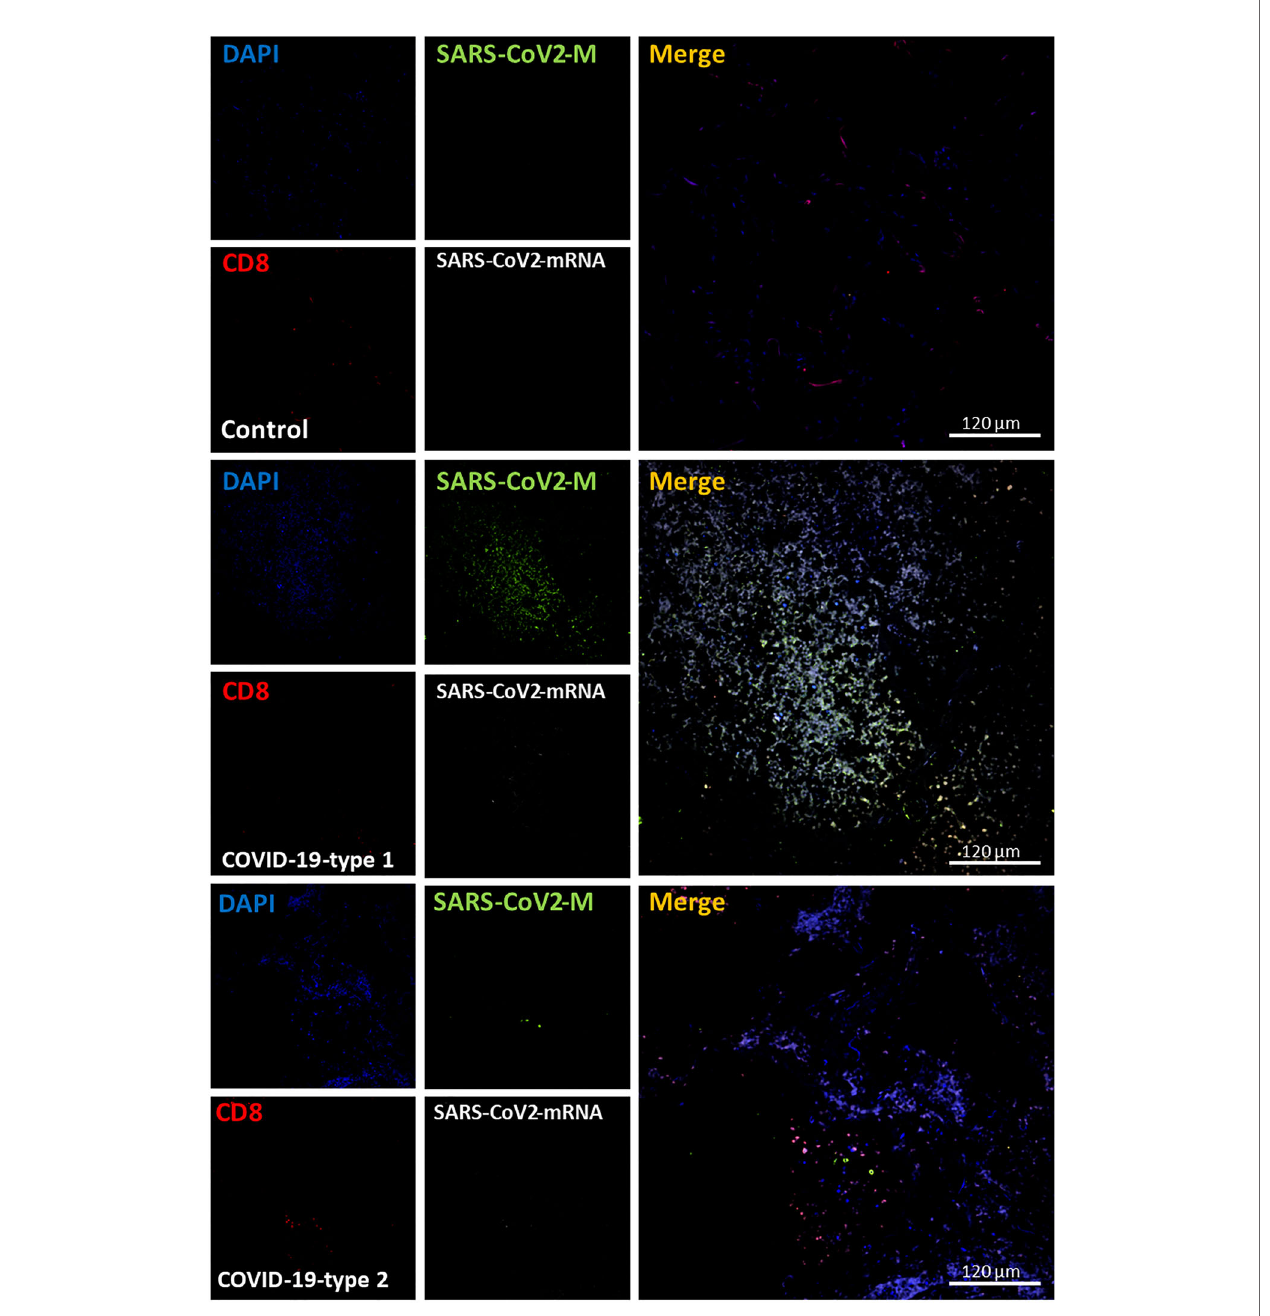
FIGURE 7 | COVID-19 disease induces a small but signi fi cant in fi ltration of CD8 + lymphocytes into the lung. Staining for nuclei (DAPI, blue staining), SARS-CoV-2 protein M (SARS-CoV-2-M, green staining), CD8 + lymphocytes (CD8, red staining), and SARS-CoV-2-mRNA (White staining) was performed. 3D reconstructions of lung samples collected from uninfected (control) and COVID-19 (Type 1 or 2, enhanced coagulation, and immune in fi ltration). In control conditions, CD8 + lymphocytes were mostly randomly attached to the alveolar wall (Control). In contrast, in the enhanced coagulation phenotype (COVID-19, type I, damage), a signi fi cant in fi ltration of lymphocytes was observed (COVID-19-type 1), but most of this in fi ltration was localized, and most areas were negative for CD8 + cells. No CD8 + lymphocytes were positive for viral mRNA or the viral protein M. As indicated in the previous fi gure, most viral protein M staining was concentrated inside blood vessels. In the immune in fi ltrating phenotype, we observed a signi fi cant increase in lymphocyte in fi ltration, but as indicated above, in fi ltration was region-speci fi c, and most areas were negative for CD8 staining. (n = 13-15 different cases analyzed with a least fi ve sections